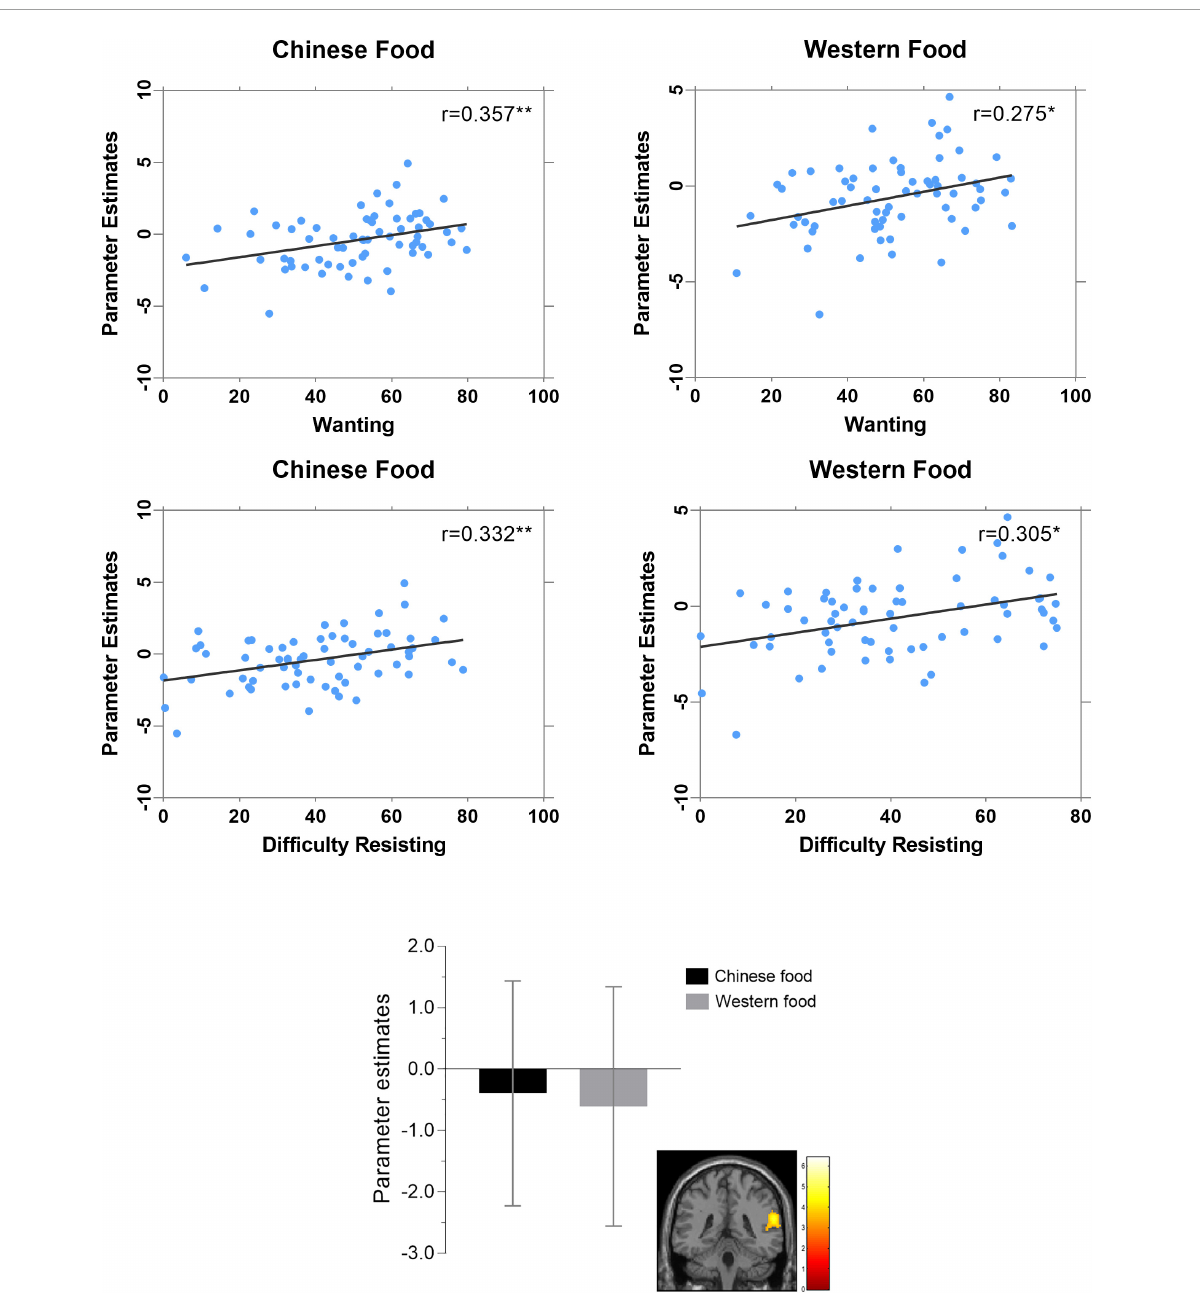
FIGURE3 Correlations of food image ratings with BOLD responses of “reward” region cluster (superior temporal gyrus, supramarginal gyrus, middle temporal gyrus, inferior parietal lobule, posterior insula) differentiating Chinese versus Western food images (* p < 0.05, ** p <